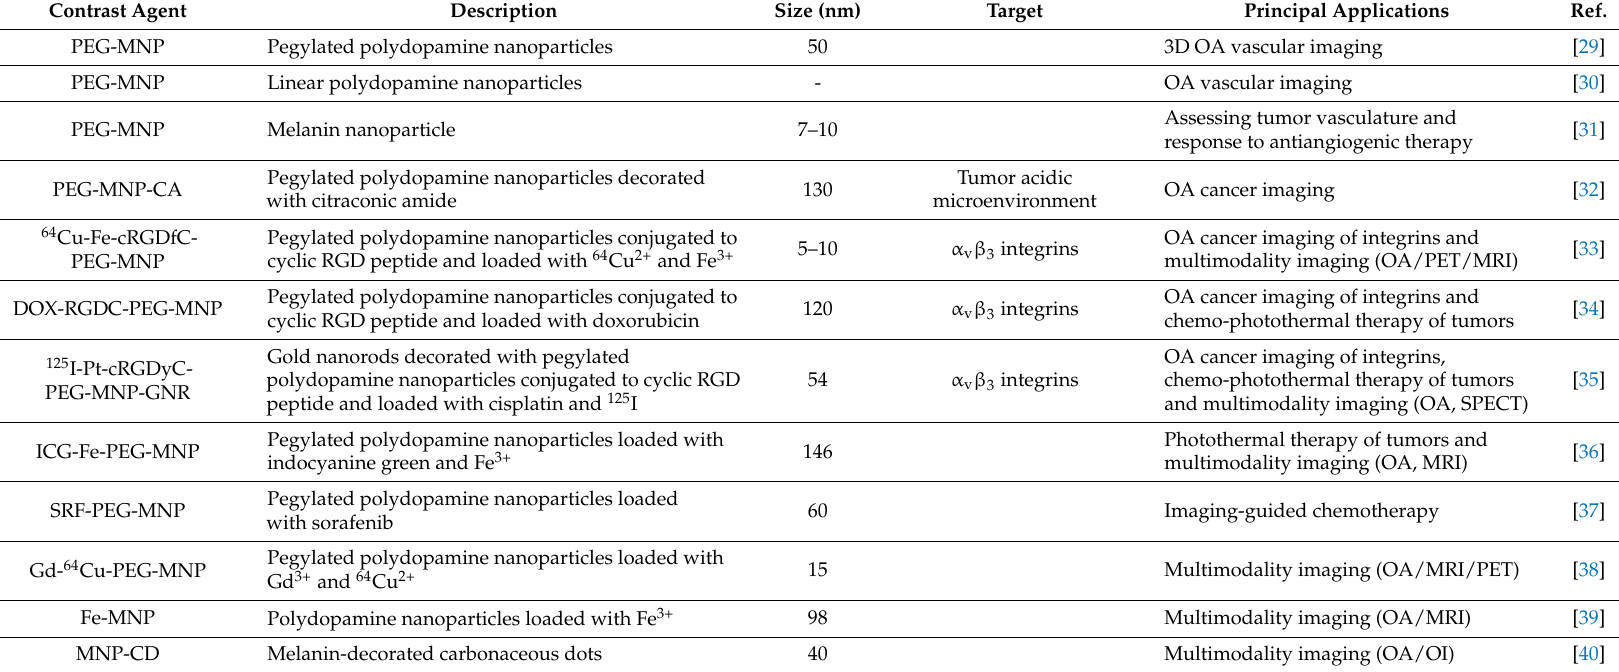
Table 1. Summary of melanin-based contrast agents for optoacoustic